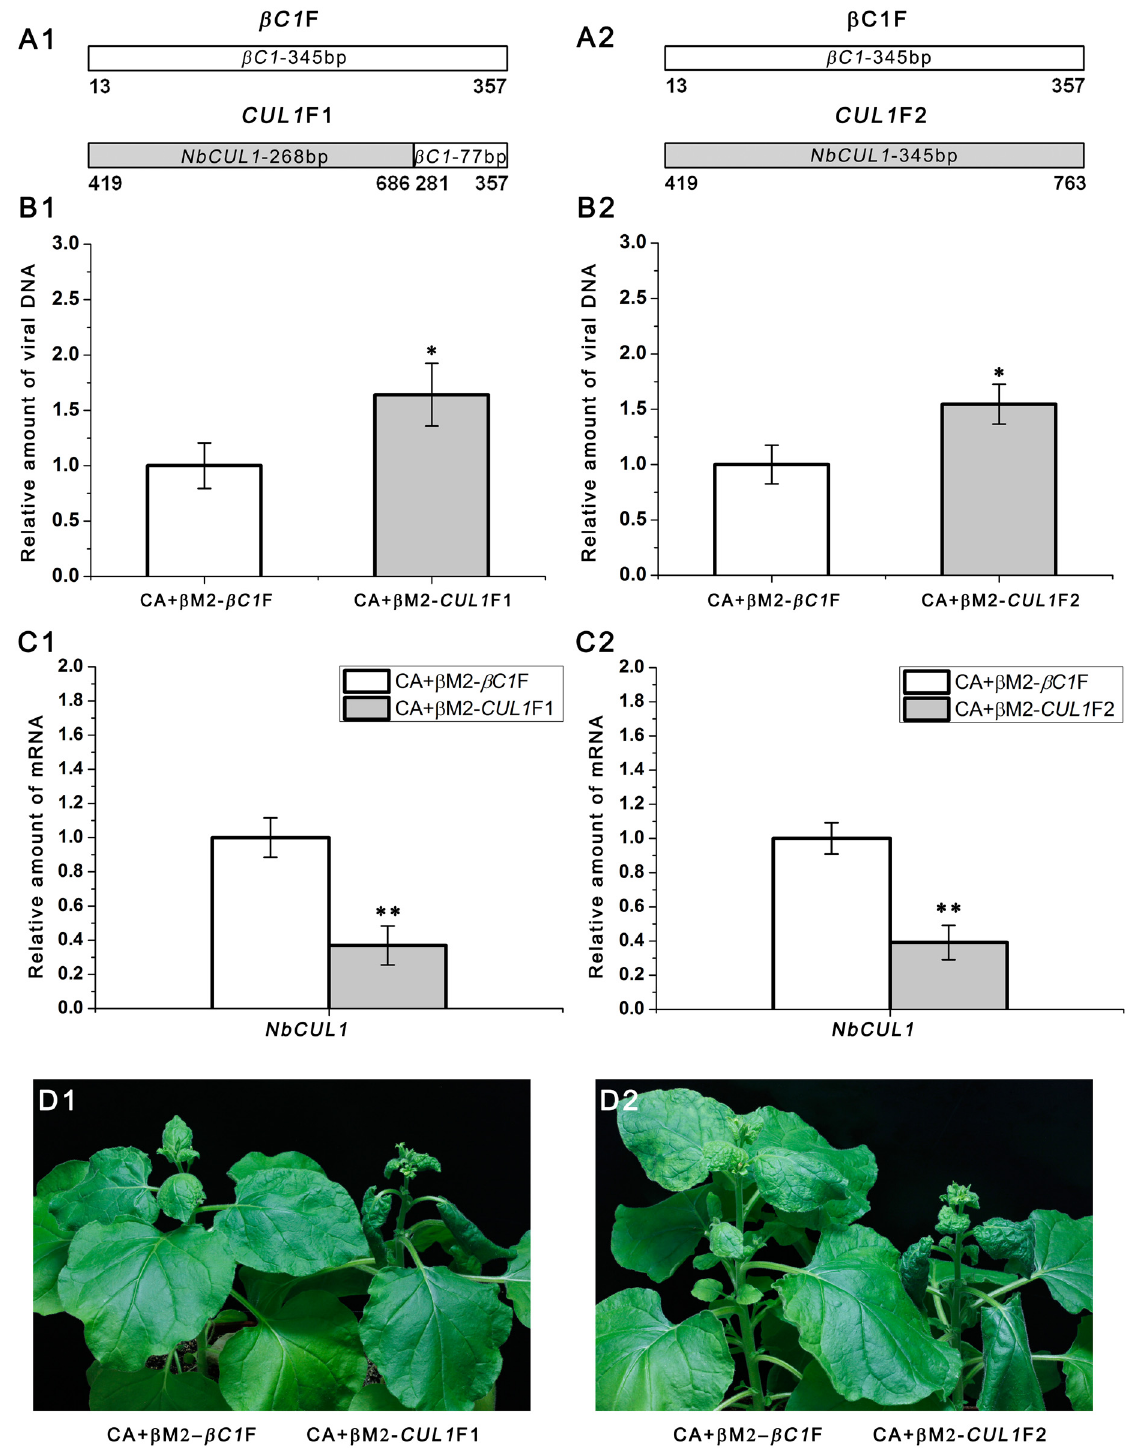
Fig 5. Silencing of NbCUL1 enhances CLCuMuV DNA accumulation and results in typical disease symptoms. (A1 and A2) Six- to seven-week-old N . benthamiana plants were agroinoculated with CLCuMuV (CA) and β M2- CUL1 F1 (A1), β M2- CUL1 F2 (A2) or β M2- β C1 F (as the control). (B1 and B2) Silencing of NbCUL1 enhanced CLCuMuV DNA accumulation. Each group contained 7 plants. At 14 dpi, total DNA was extracted from each plant respectively and subjected to quantitative real-time PCR (means ± SEM, n = 7) to quantify viral DNA accumulation. The internal reference method was used to calculate the relative